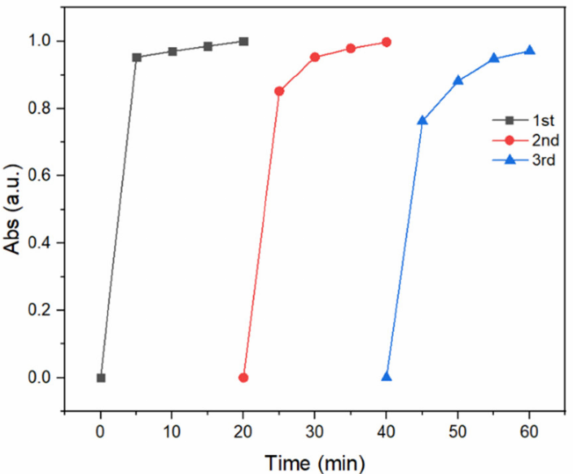
Figure 7. MB dye degradation efficiency of using C,N-doped FeBO 3 for consecutive three experiments. The mass of catalyst used was 50 mg, 16 mg, and 9 mg,